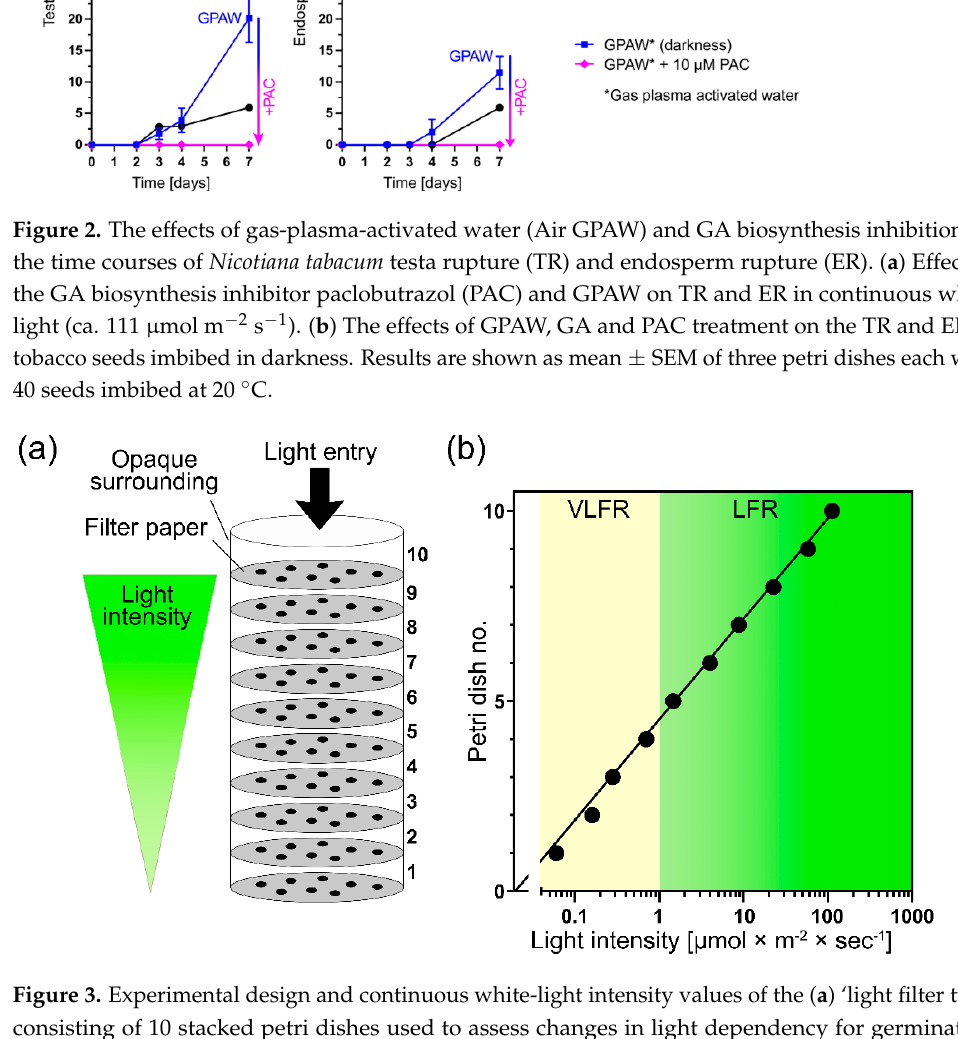
Figure 3. Experimental design and continuous white-light intensity values of the ( a ) ‘light filter tube’ consisting of 10 stacked petri dishes used to assess changes in light dependency for germination of dormant Nicotiana tabacum seeds. The dishes were wrapped in opaque material, limiting light access to the top of the petri dishes and generating an exponential decreasing light intensity through each layer. ( b ) White-light intensities in the petri dish stack are expressed as photon fluence rate ( µ mol m − 2 s − 1 ). The very low fluence response range (VLFR) is shaded yellow (<1 µ mol m − 2 s − 1 ), and the low fluence response (LFR) range is on the right segment of the graph (>1 µ mol m − 2 s − 1